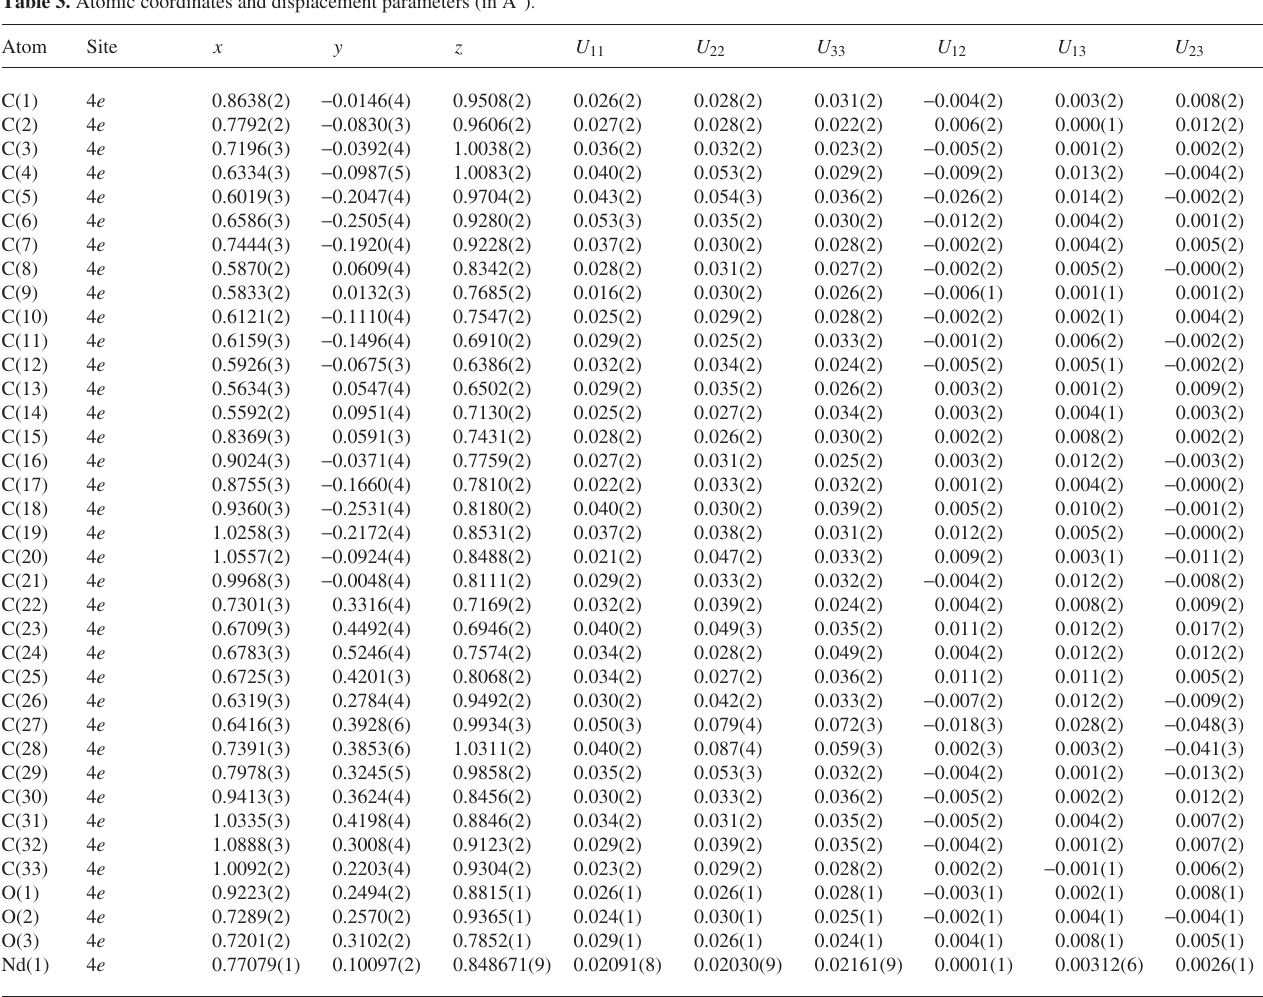
Table 3. Atomic coordinates and displacement parameters (in Å 2 )